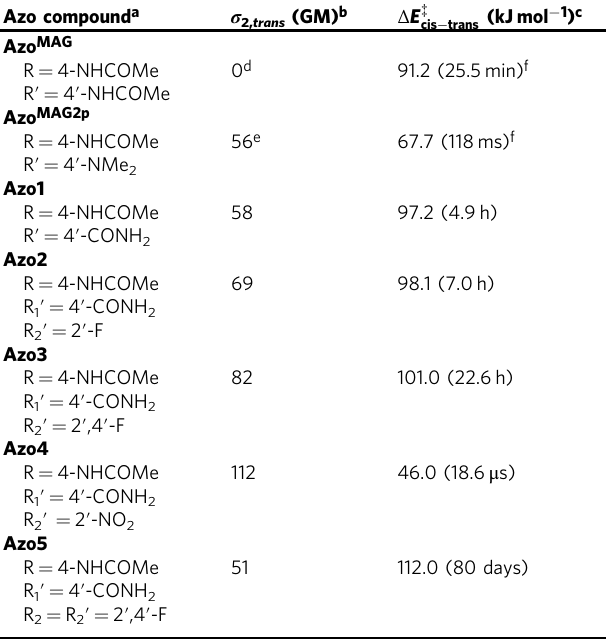
Table 1 2P absorption cross sections and cis thermal stabilities of model azo compounds in water Azo compound